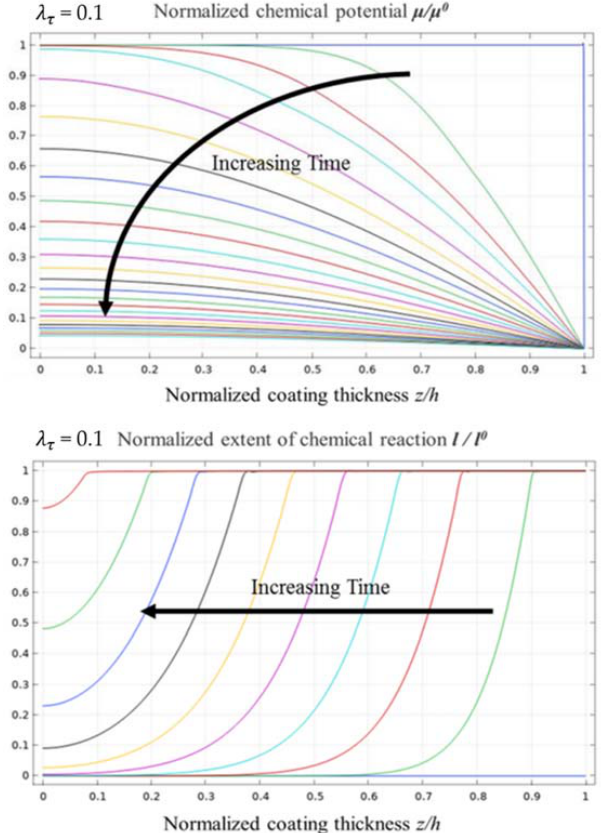
Figure 5. Evolution curves of normalised chemical potential and normalised chemical reaction degree when λ τ = 0.1.